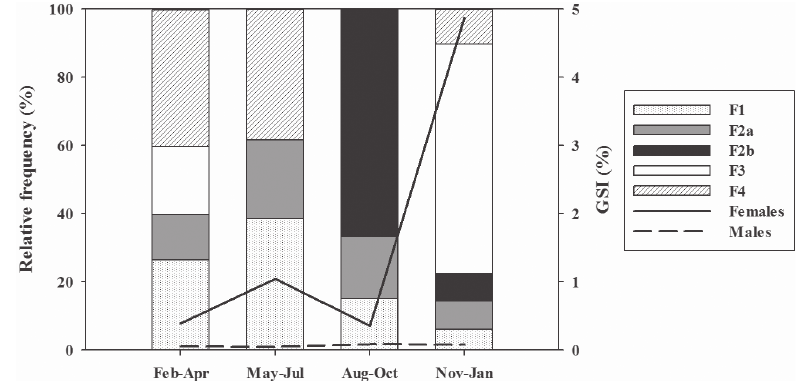
Figure 6 - Seasonal variation in GSI of females (continuous line) and males (discontin- uous line) and relative frequency of gonadal stages in females of H. francisci captured in Itapecerica River. F1 = females in stage 1 (regenerating), F2a = females in stage 2a (initial developing); F2b = females in stage 2b (advanced developing); F3 = females in stage 3 (spawning capable); F4 = females in stage 4